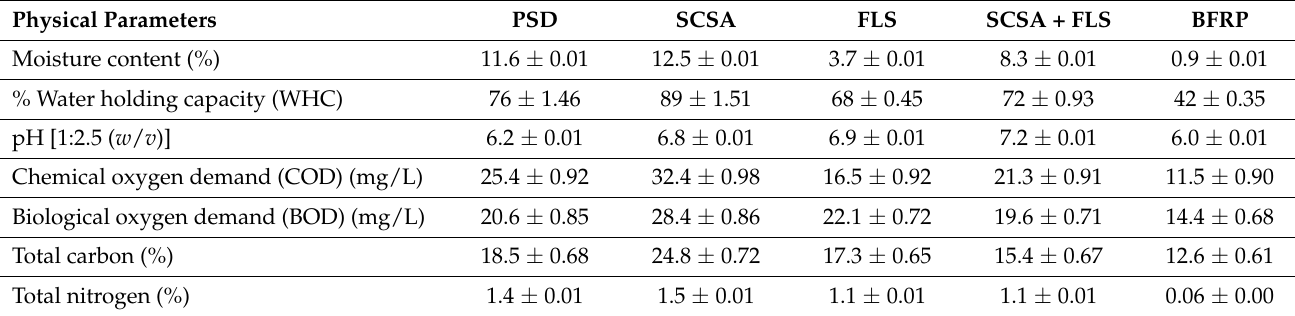
Table 1. Physico-chemical properties of different supporting